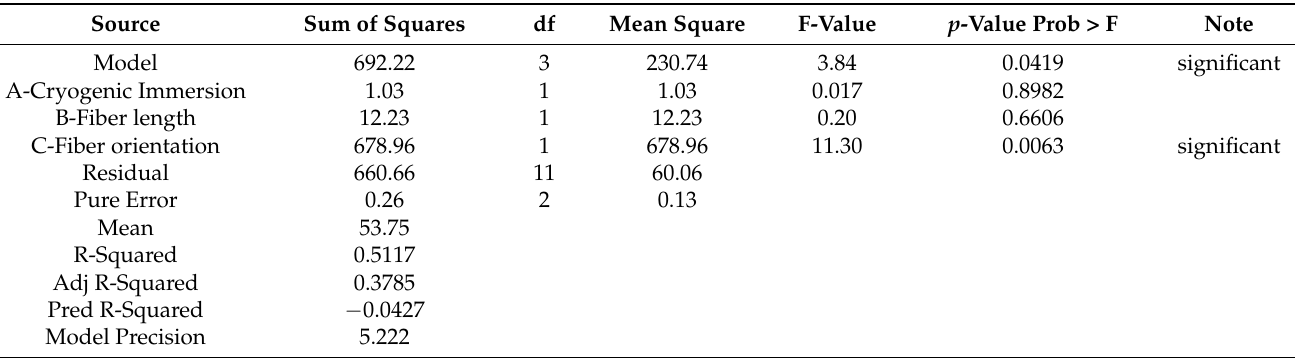
Table 5. ANOVA for flexural